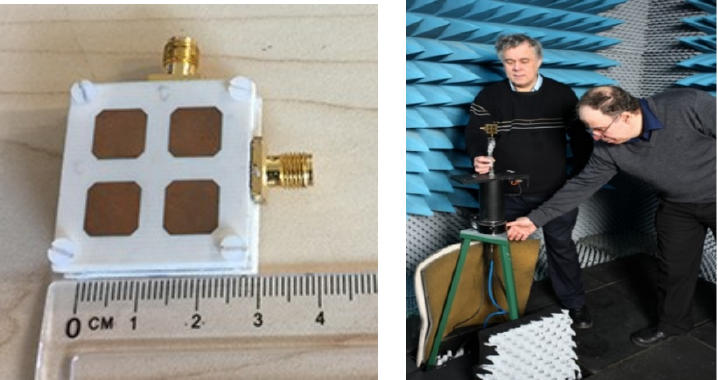
Figure 10. The wideband MIMO antenna prototype (left) and far field measurement facility (right).